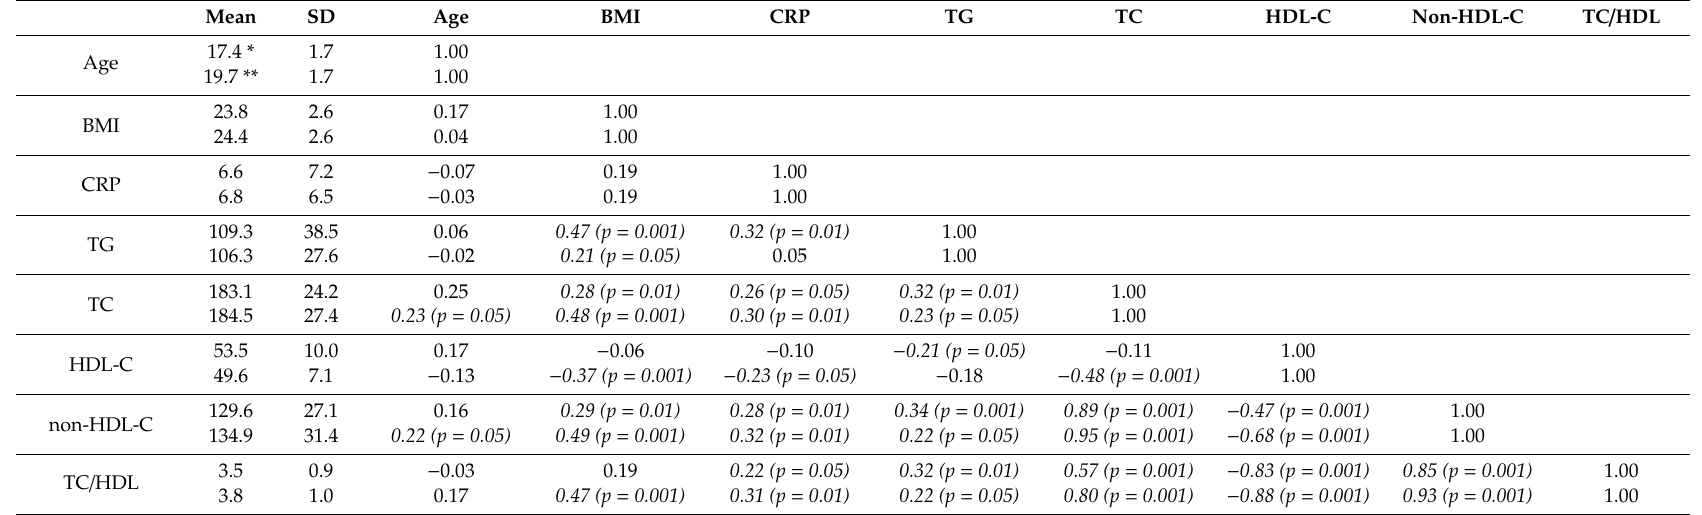
Table 2. Spearman correlation coe ffi cient matrix between age, BMI, CRP and lipid profile determined in investigated patients and healthy volunteers according to first and second assessment